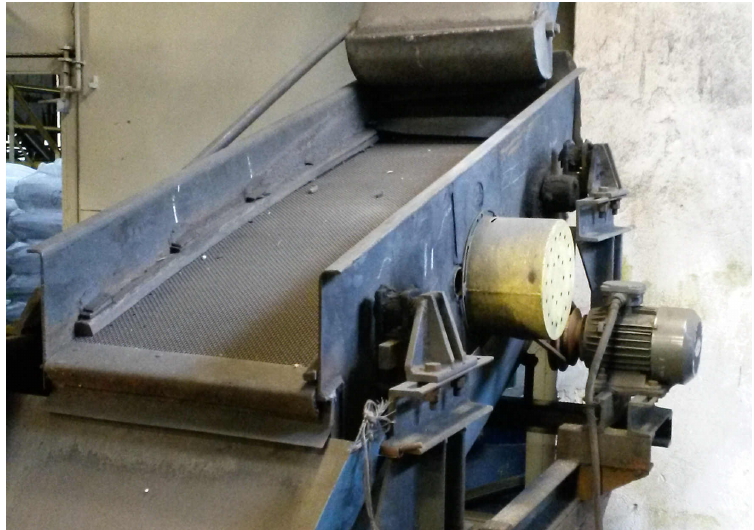
Figure 1. A semi-industrial vibrating screen with a single mechanical exciter based on rotating unbalanced